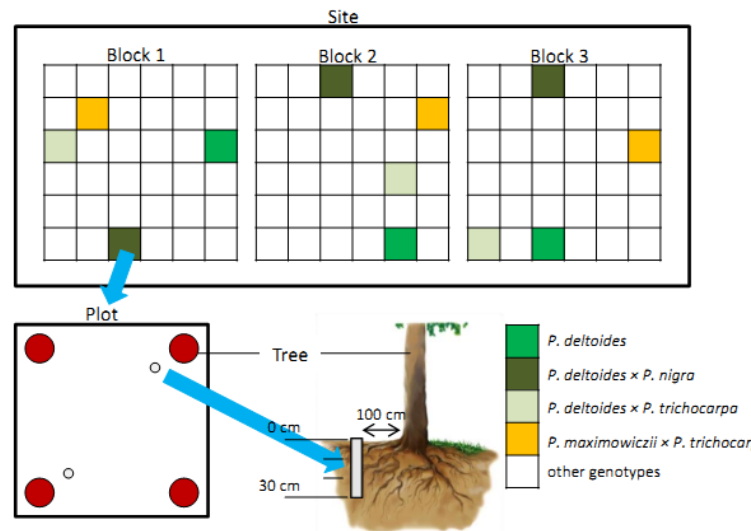
Figure 1. Localization of the study sites.